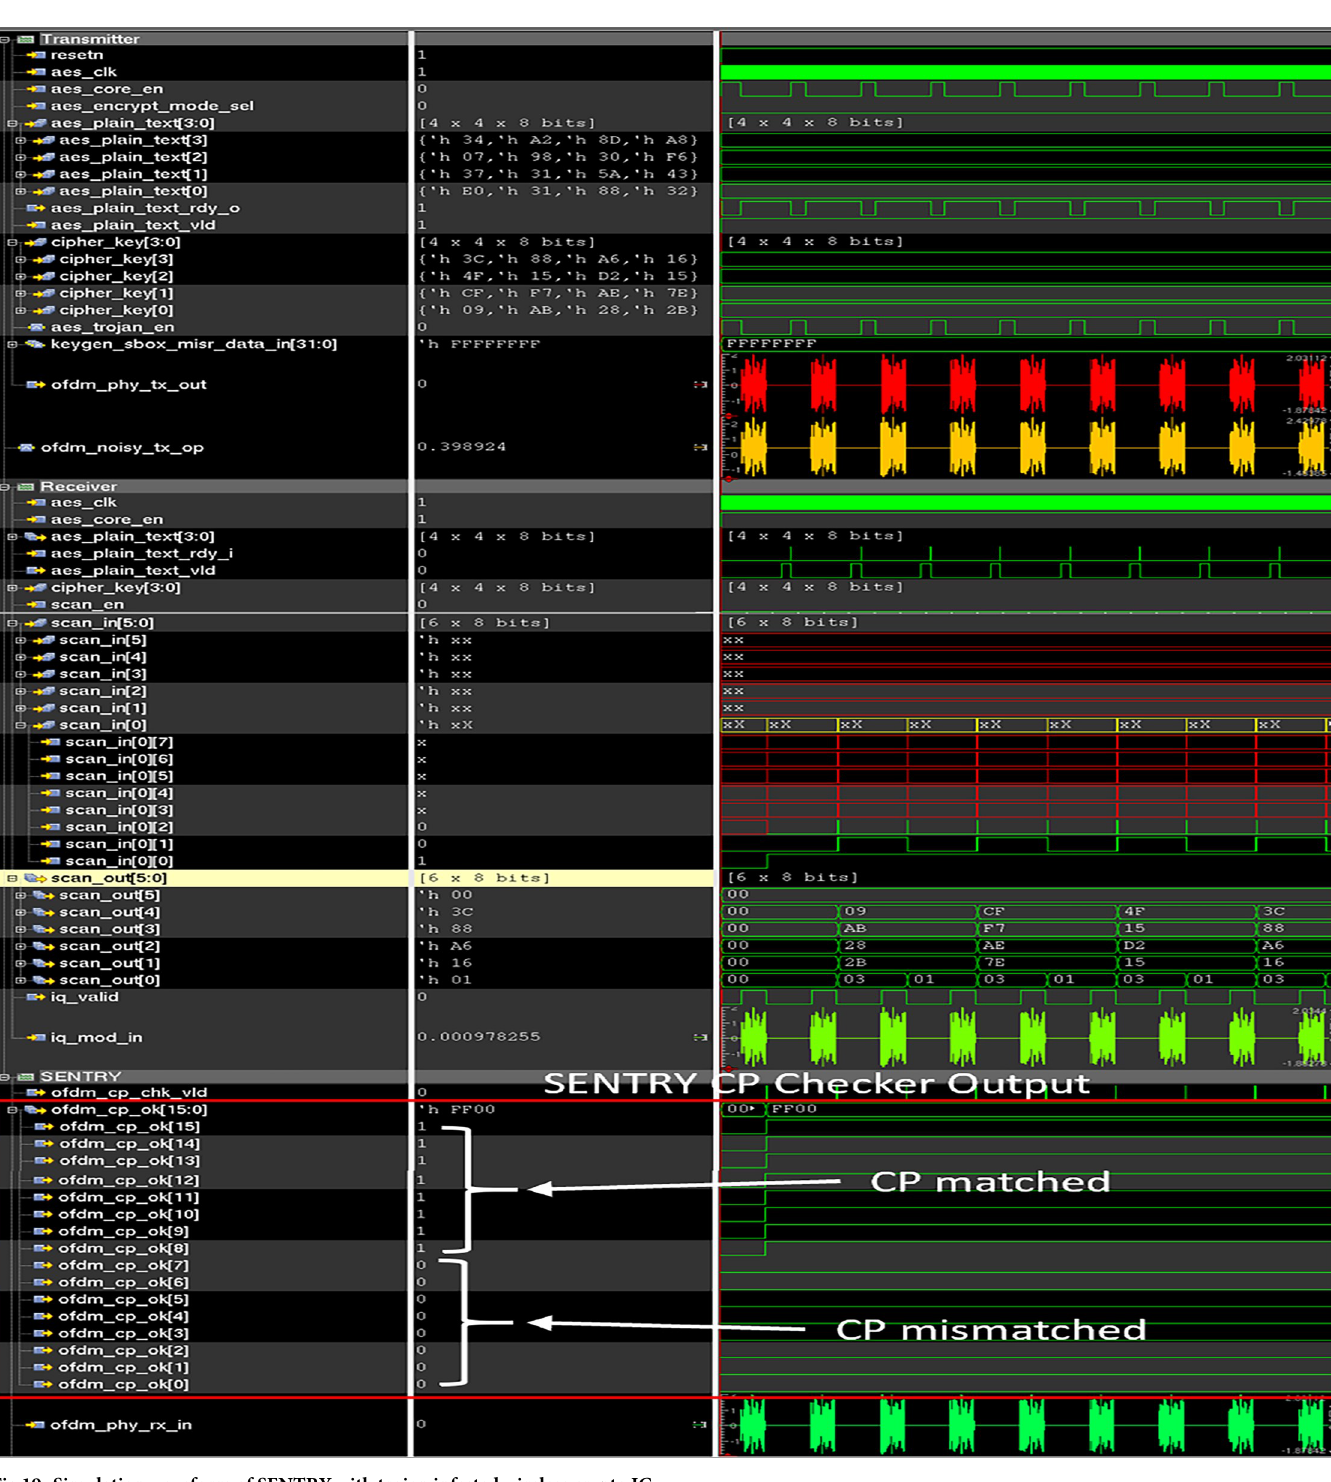
PLOS ONE | https://doi.org/10.1371/journal.pone.0254903 July 29, 2021 20 /